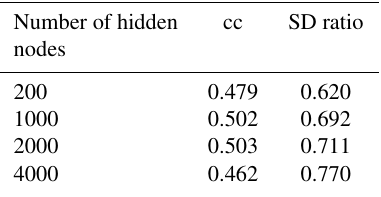
Table B5. Different hidden-node amounts in each layer, with the rest of the parameters fixed as in Table B1.